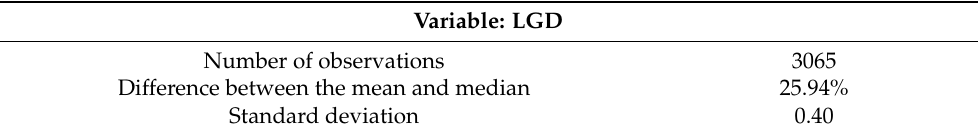
Table 6. SA Build data statistics (Data set